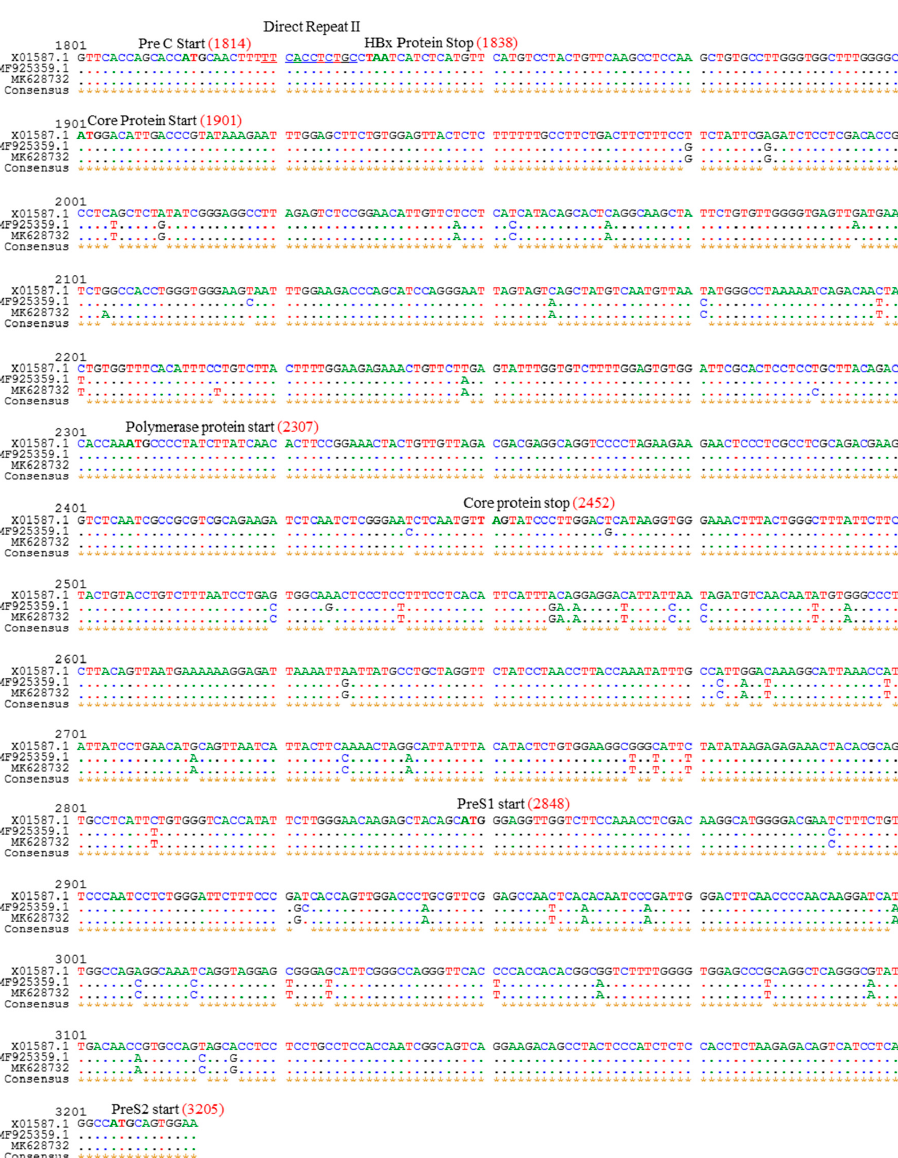
Figure 2. Alignment of HBV full genome sequence with that of reference strains. The HBV complete genome sequence identified in this study was aligned with reference strains MF925359.1 and X01587 and characterized. Mutational analysis was performed by comparing the present sequence with that of the reference HBV genomes.